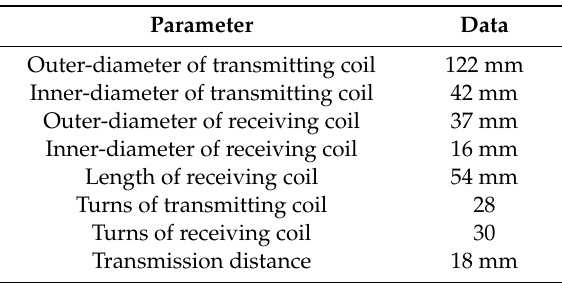
Table 1. Parameter of the coil.